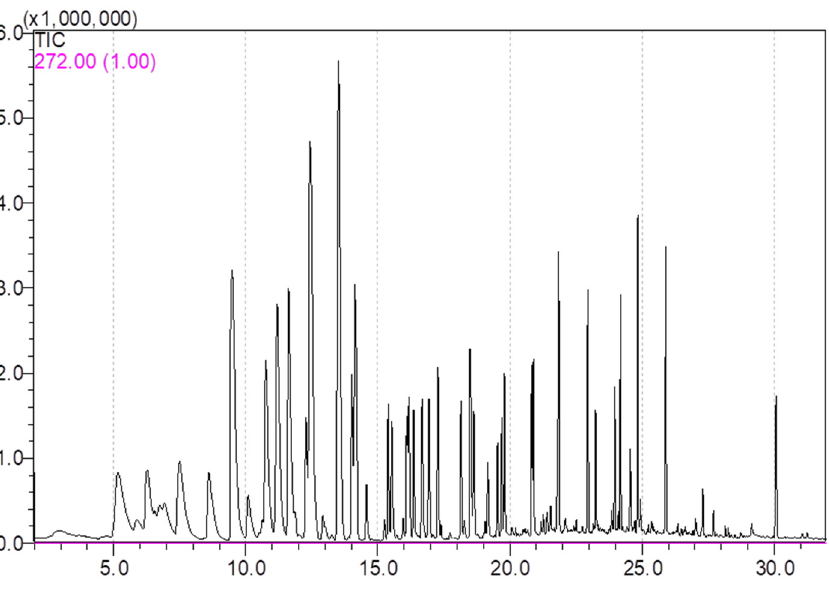
Figure 1. Total ion current (TIC) chromatogram graph for 1 internal standard and 39 external standards.